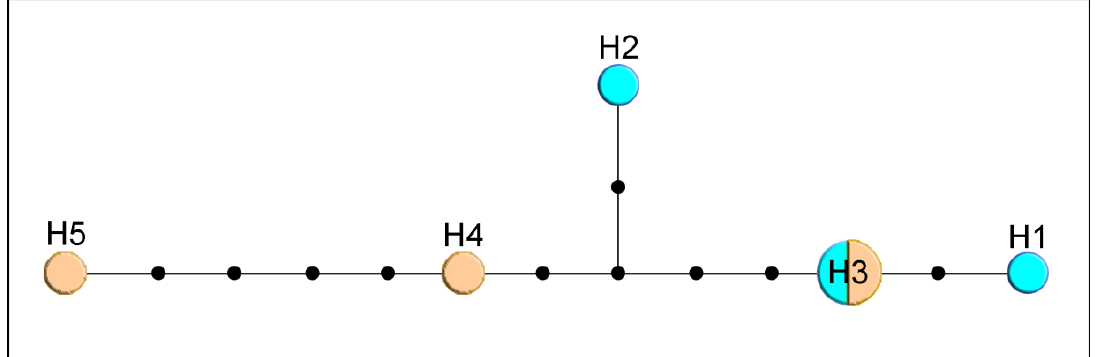
Figure 3. Haplotype network based on COI sequences of specimens identified as M. ligustri (blue) and M. mali (beige). Size of circles indicate the number of specimens with a haplotype; black dots represent one nucleotide substitution.